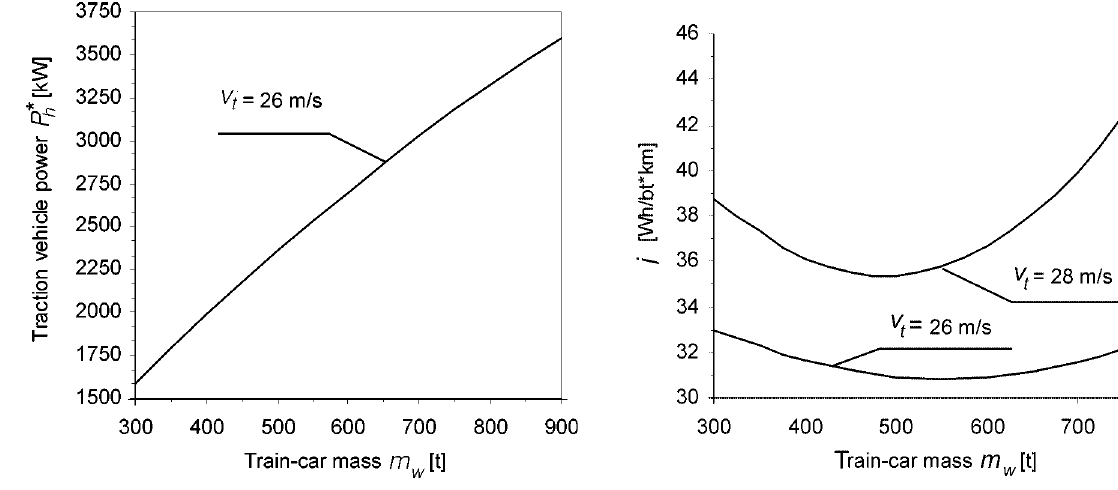
∗ Fig 3. Variations of traction vehicle optimal power h P Fig 4 . Variations of unitary total energy consumption depending on train-car mass for technical speed 26 = t ν m/s depending on train mass for technical speed 26 = t ν along segment 15 = k s km and 28 m/s along segment 15 = k s